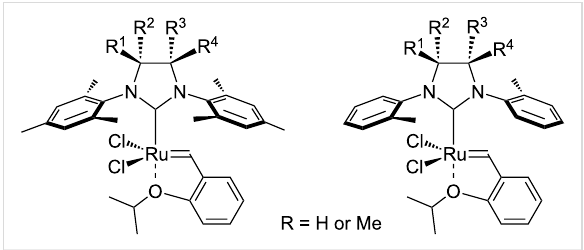
Figure 2: Highly active olefin metathesis catalysts bearing NHC with backbone